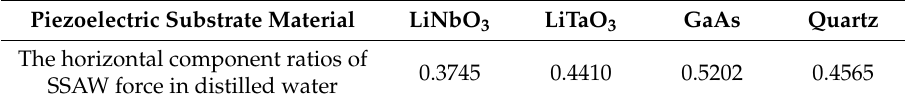
Table 1. The horizontal component ratios of SSAW force in distilled water for LiNbO 3 , LiTaO 3 , GaAs, and